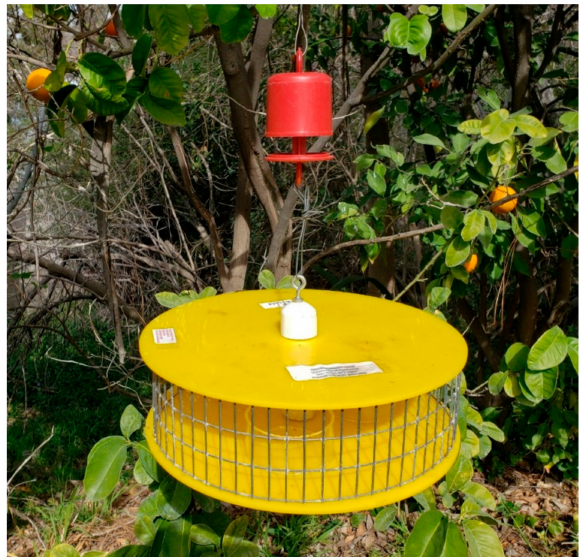
Figure 4. The UCR plastic circular bait stations and ant guard used at the San Diego Zoo Safari